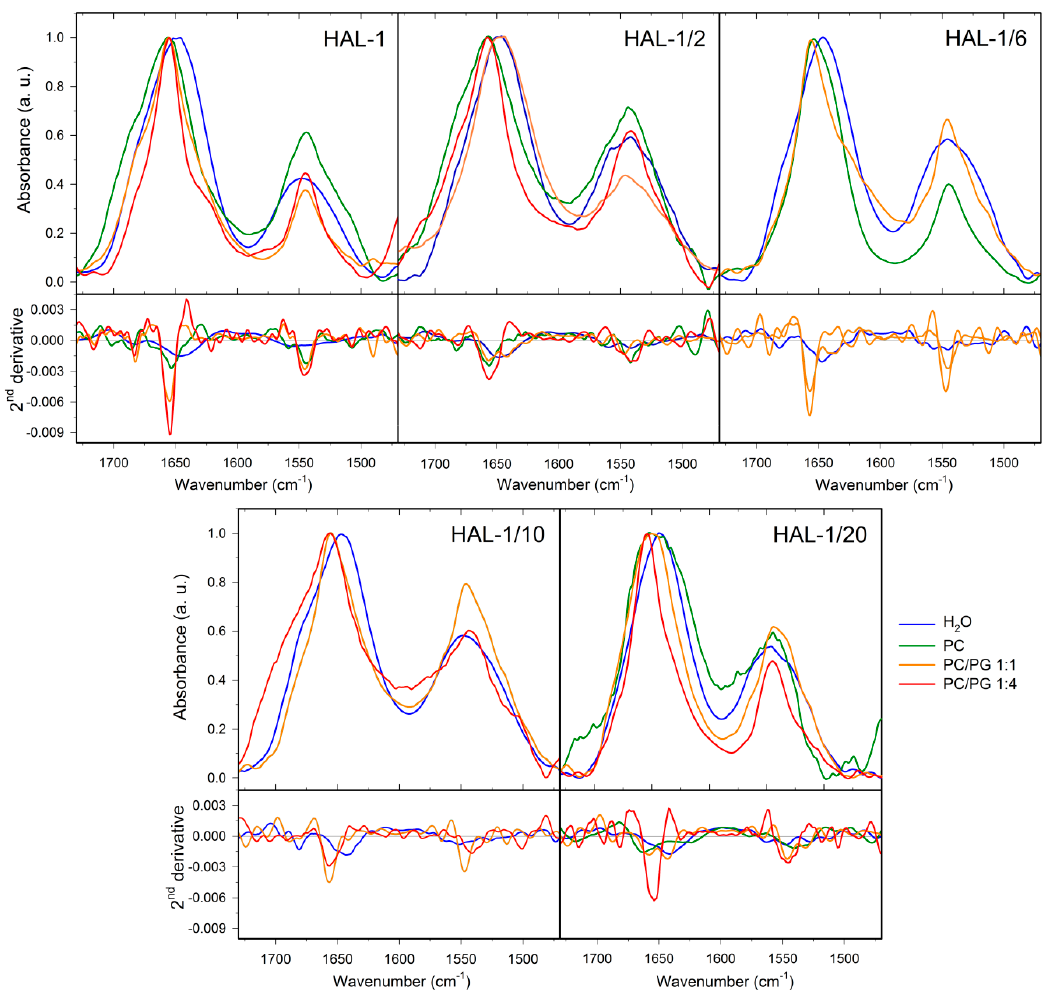
Figure 8. IR spectra ( top ) and their second derivatives ( bottom ) of HAL-1 and its analogs (10